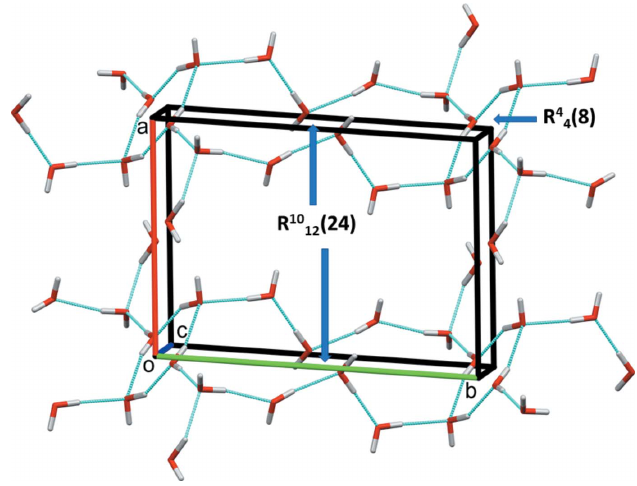
Figure 4 Aview along the c axis of the hydrogen-bonded network of solvent water molecules (see Table 2).